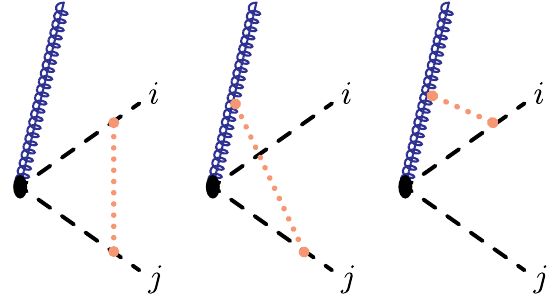
Figure 3 . One-loop Glauber exchange diagrams in low energy EFT without any additional soft emission. The q 1 gluon, while soft in the full theory, has now become a collinear mode. The Glauber exchanges shown here correspond to lower transverse momentum